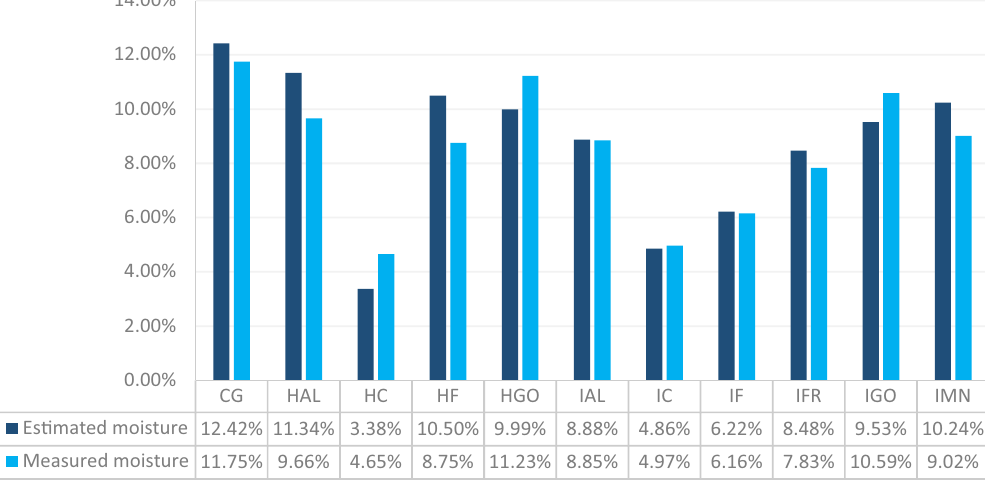
manganiferous itabirite (IMN), high-grade soft itabirite (IFR), soft hematite (HF), compact hematite (HC), goethite–hematite (HGO), aluminous hematite (HAL) and canga (CG)